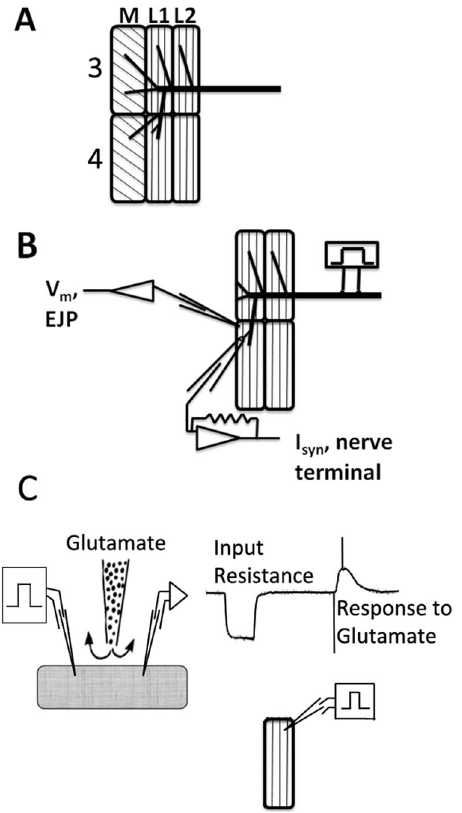
Figure 1. Experimental preparation. A . Deep abdominal extensor muscles M, L1 and L2 were exposed in abdominal segments 3 and 4. B . EJPs and synaptic currents were recorded using intracellular and loose patch electrodes, respectively. C . Iontophoresis was onto muscle segment 4 as close as possible to the neuromuscular junction.